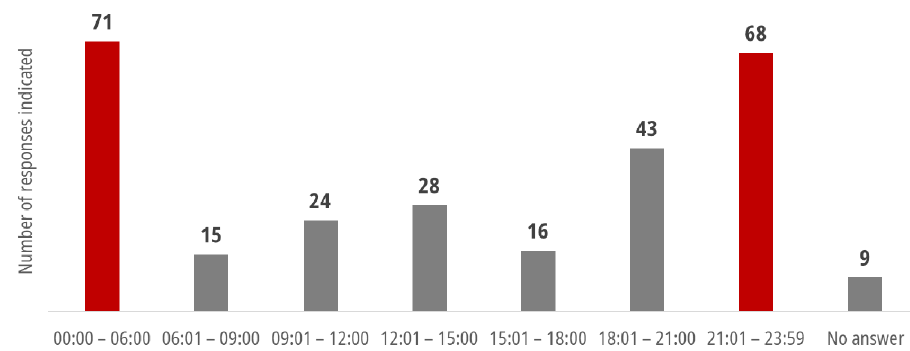
Figure A8. Responses to question